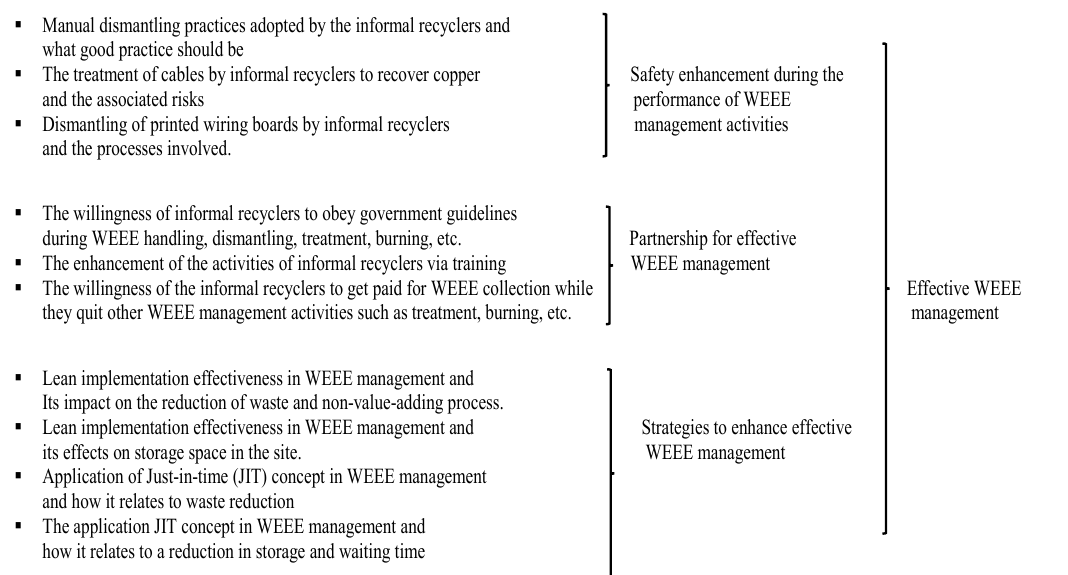
Figure 3. Effective WEEE management and associated themes.